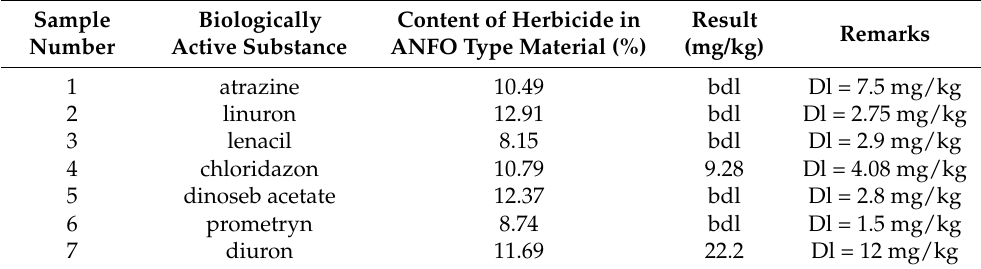
Table 3. Results of the determination of herbicide residue in soil.